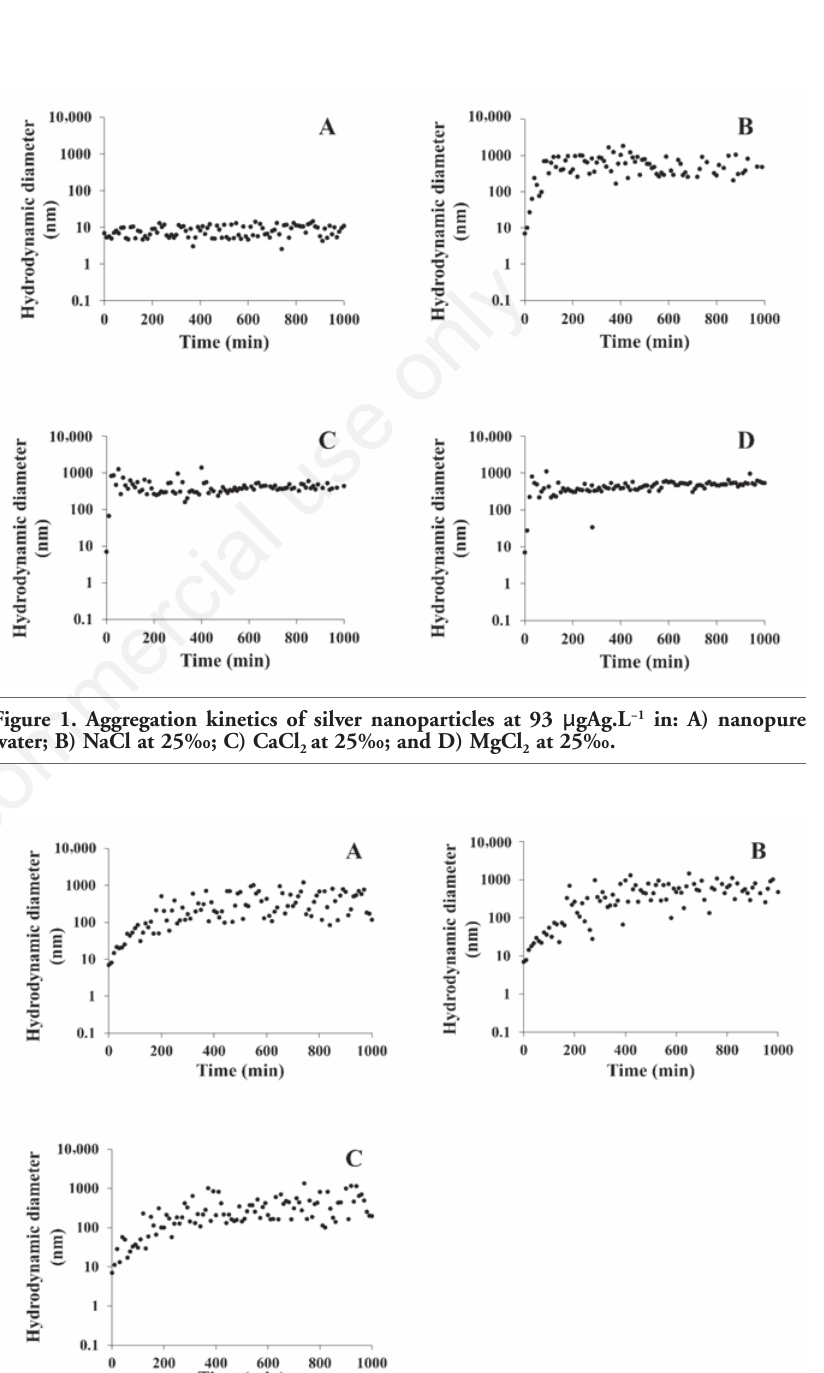
Figure 2. Aggregation kinetics of silver nanoparticles at 93 water; B) F/2 media; and C) LB